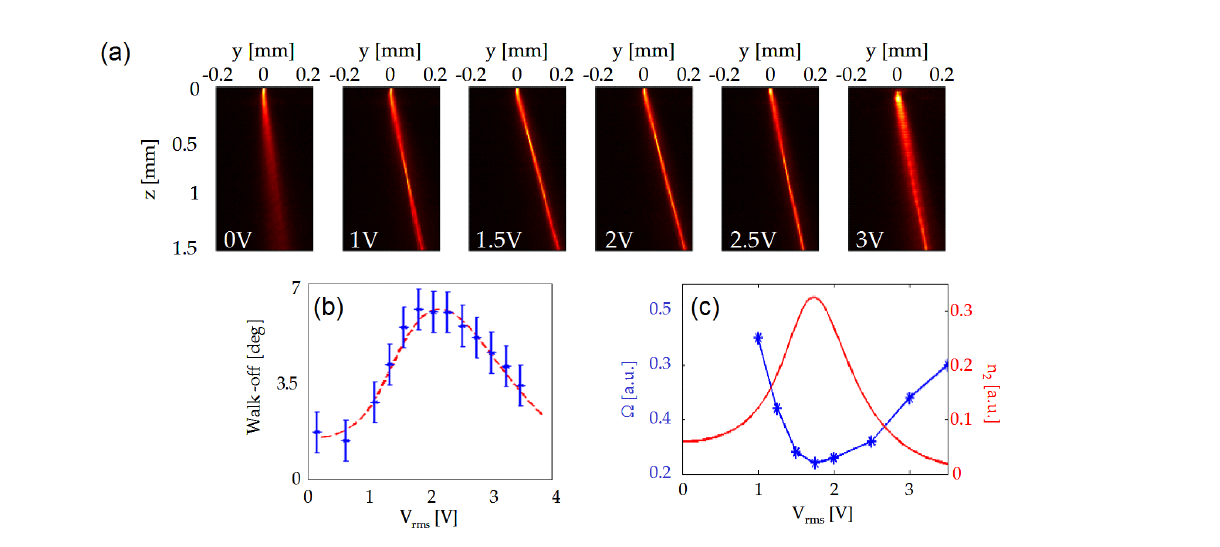
( a ) Photographs of λ = 1064 nm nematicons steered in a sample with interdigitated electrodes as in Figure 7 for various applied voltages, V ; ( b ) Measured (blue dots) and theoretical (red dashed line) walk-off versus bias; ( c ) Comparison between the equivalent nonlinear coefficient n (red solid line) and the nematicon breathing period Ω 2 (blue stars) versus applied